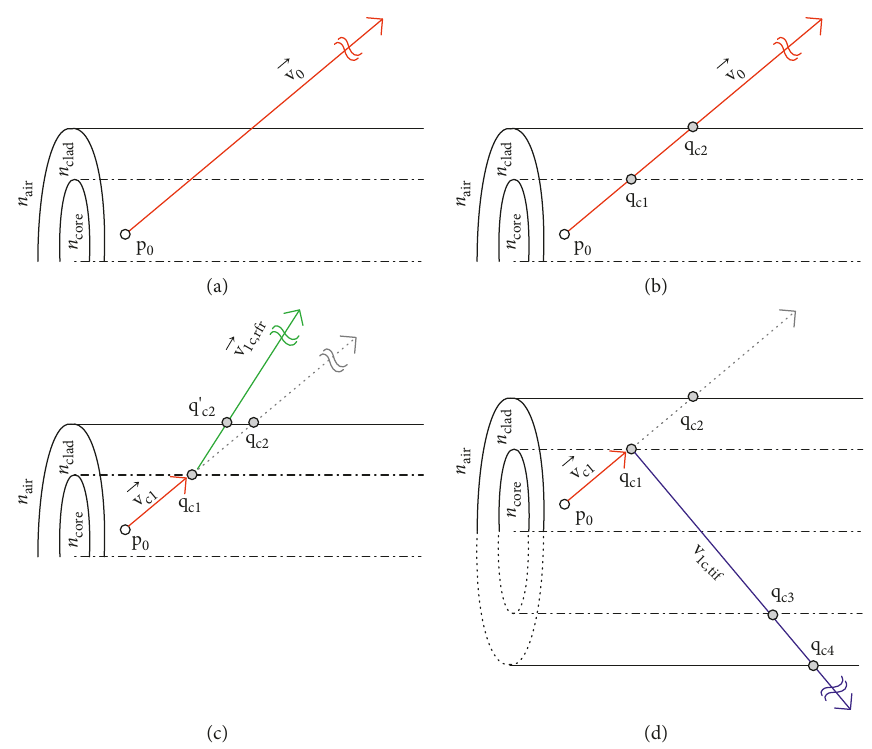
Figure 6: Diagram of the proposed large-time-step-based ray-tracing.